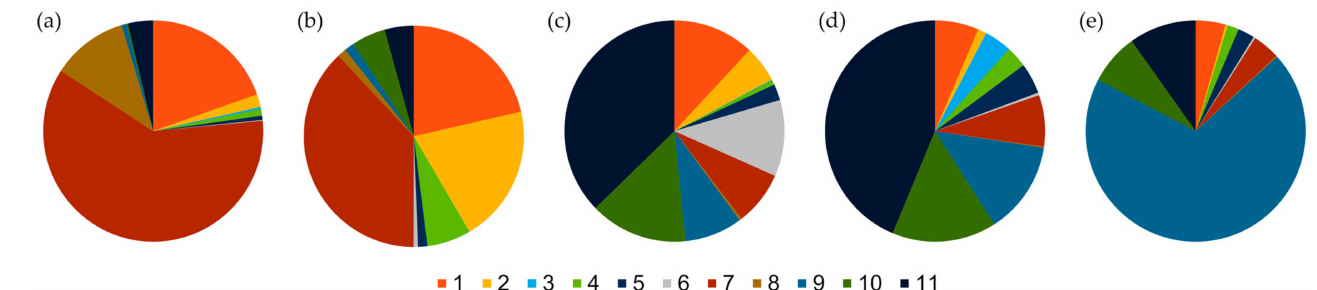
Figure 10. Proportion of 11 gene pools in five breeding periods of spring barley based on population structure analysis. ( a ) Cultivars bred before 1945; ( b ) cultivars bred between 1945 and 1969; ( c ) cultivars bred between 1970 and 1989; ( d ) cultivars bred between 1990 and 1999; ( e ) cultivars bred after